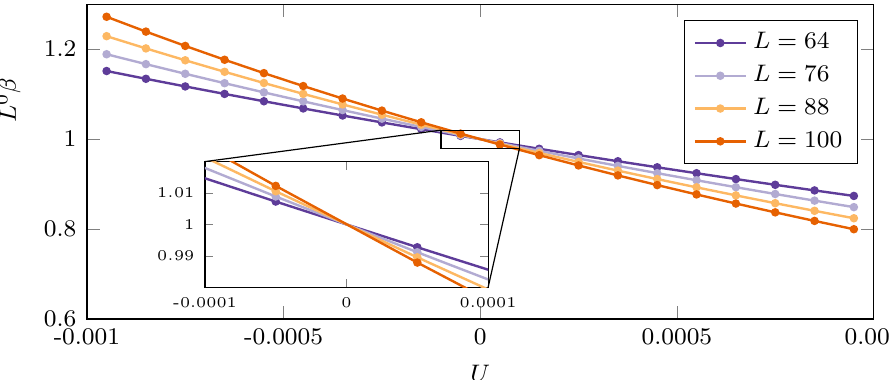
Figure 5: The Callan–Symanzik β function for the U ( τ